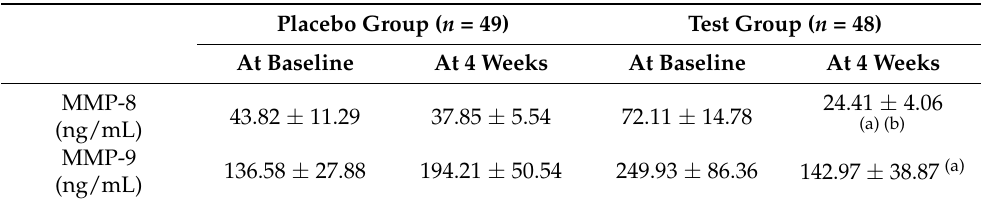
Table 4. Mean changes in matrix metalloproteinase-8 (MMP-8) and matrix metalloproteinase-9 (MMP-9) by groups. Data are presented as the mean ± SE. Placebo Group ( n = 49) Test Group ( n = 48) At Baseline At 4 Weeks At Baseline At 4 Weeks MMP-8 43.82 ± 11.29 37.85 ± 5.54 (ng/mL) 136.58 ± 27.88 194.21 ± (ng/mL)